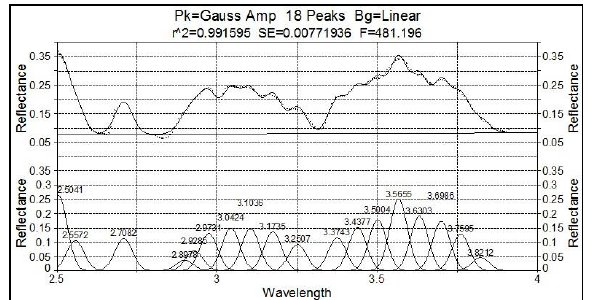
Figure 10: PeakFit separation of peaks between